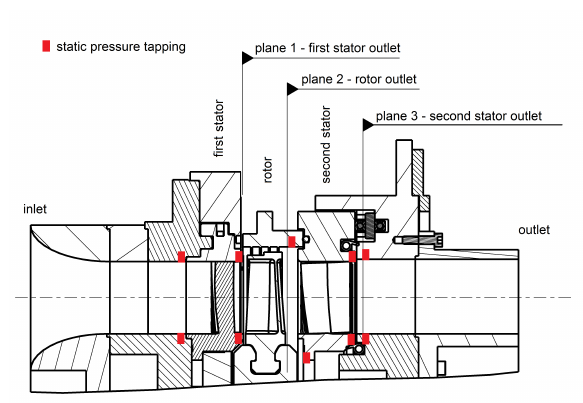
Figure 1. The one and half stage cofiguration of the test